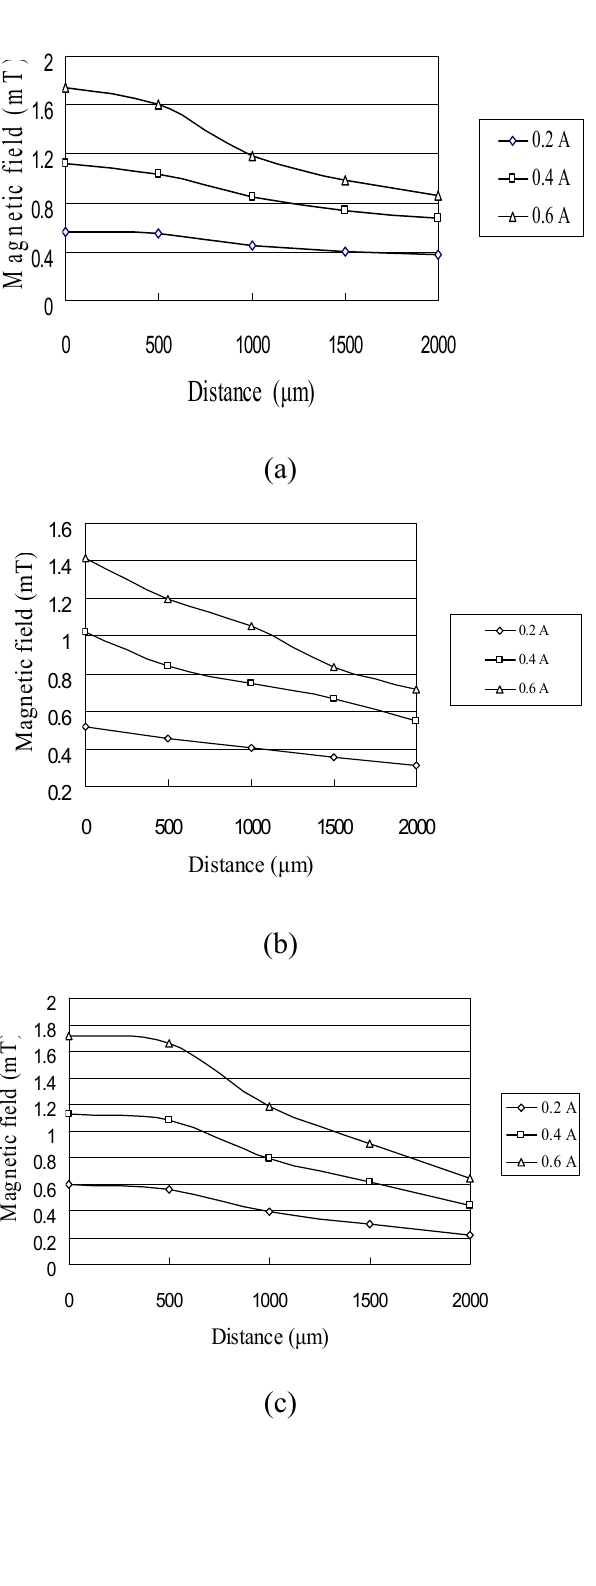
Figure 4. Variation of flux density with distance as function of input current for micro- coils with different widths: (a) 125 μ m, (b) 100 μ m and (c) 75 μ